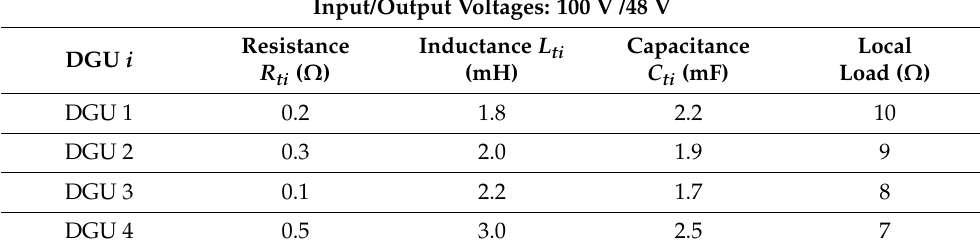
Table 2. Buck converters and filter parameters.